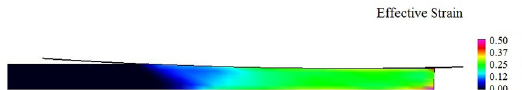
Figure 7. Effective strain - thickness of 1.0 mm, velocity of 250.00 mm/s and reduction of 30% (simulation 4).